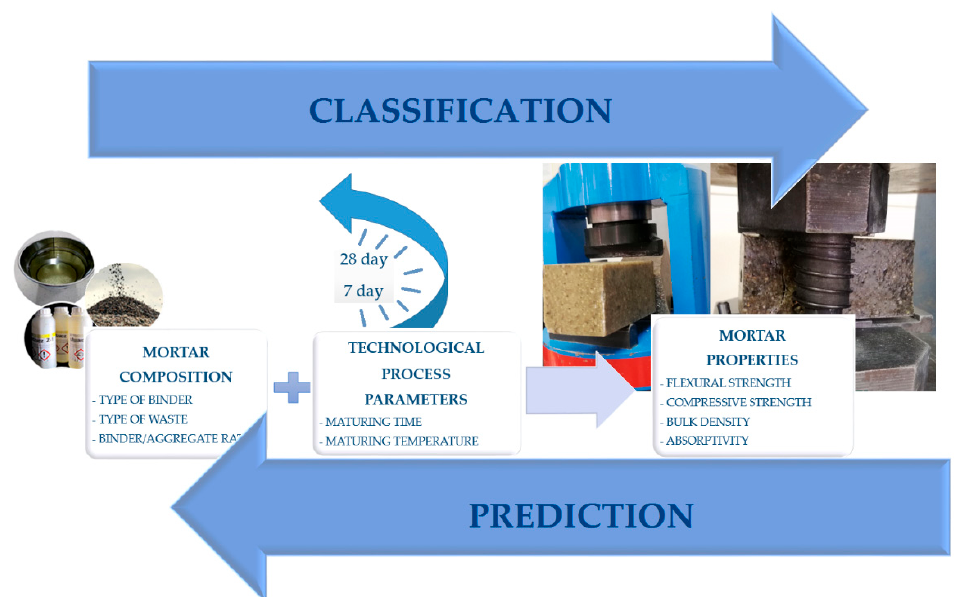
Figure 2. Diagram of the technological process of obtaining mortars.